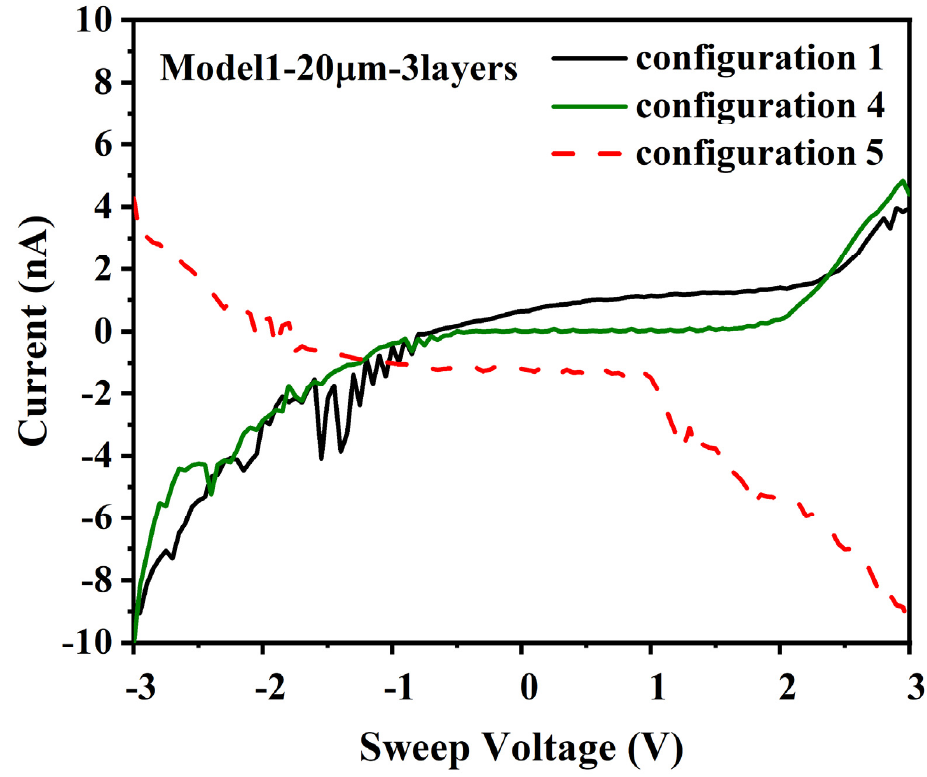
Figure 6. I/V curves for 20 µ m gap, 3 layers, and voltage applied to: (configuration 1) A1, B-1B3 grounded; (configuration 4) A1, B3 grounded, B1 and B2 float; (configuration 5) B1-B3, A1